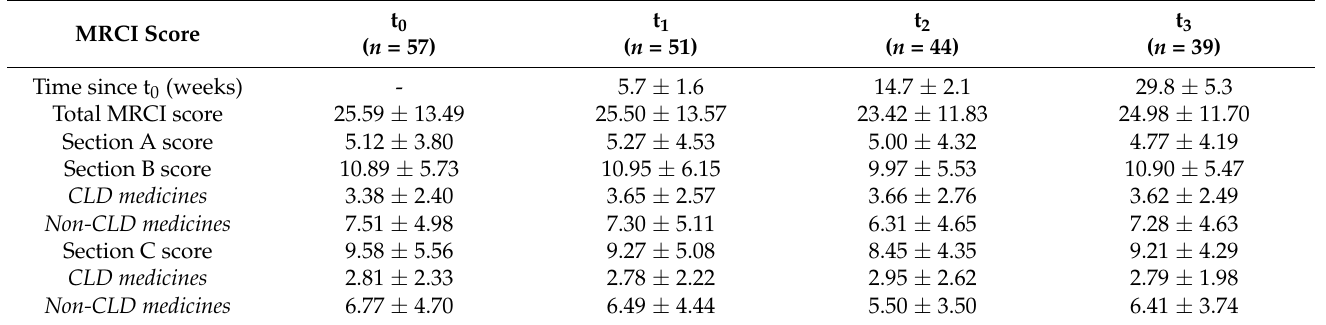
Table 4. Medication Regimen Complexity Index score over time among intervention participants. MRCI